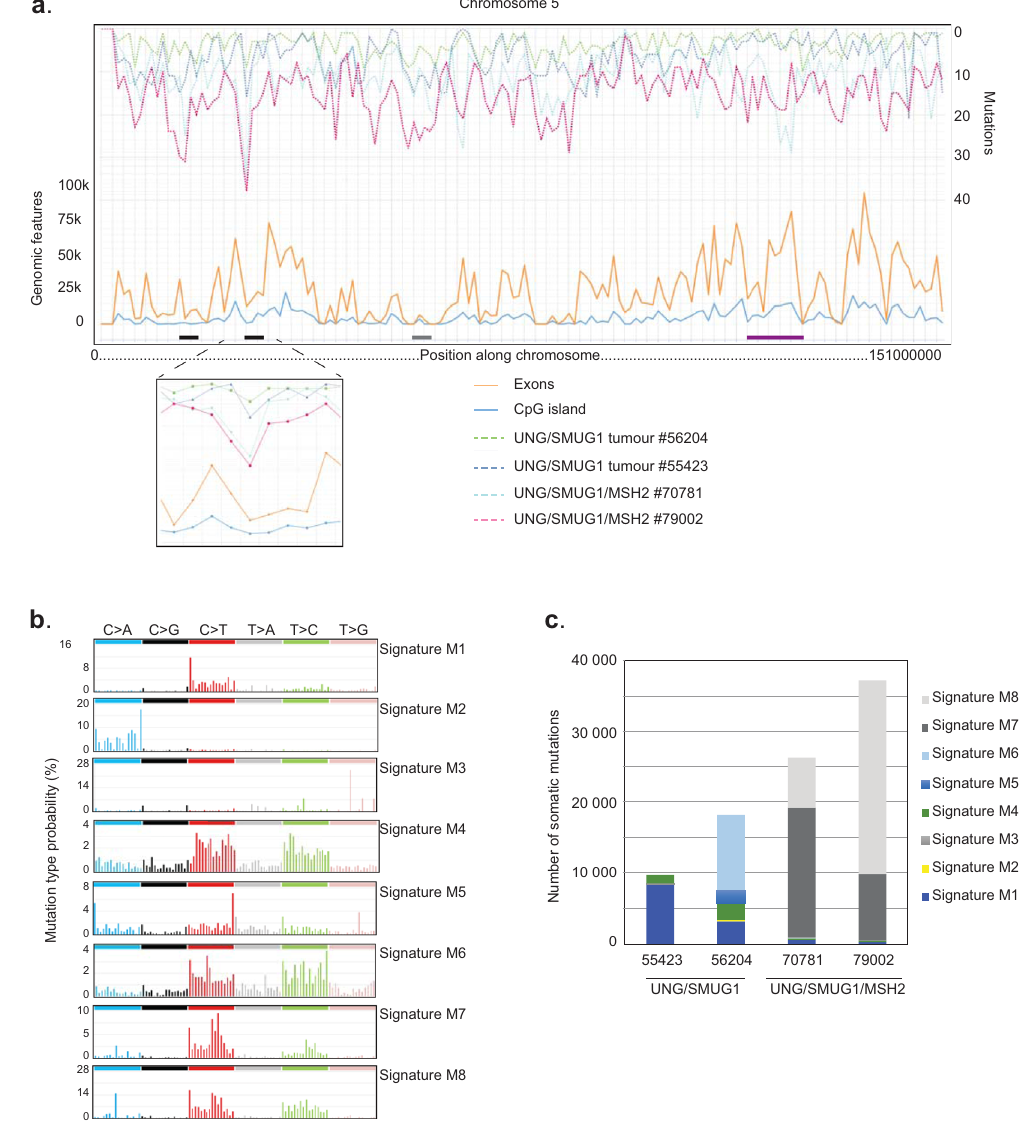
Figure 5. Mutational signatures. ( a ) Plot showing the mutation density (no. mutation/Mbp) along chromosome 5 for all four tumours together with the density of exons (orange) and CpG islands (blue). The 22–30 Mbp region with highest number of mutations is shown below. ( b ) Mutational signatures identified in the UNG/ SMUG1 and UNG/SMUG1/MSH2 tumours. ( c ) The different mutational signatures present in each tumour given as the number of mutations contributed to each